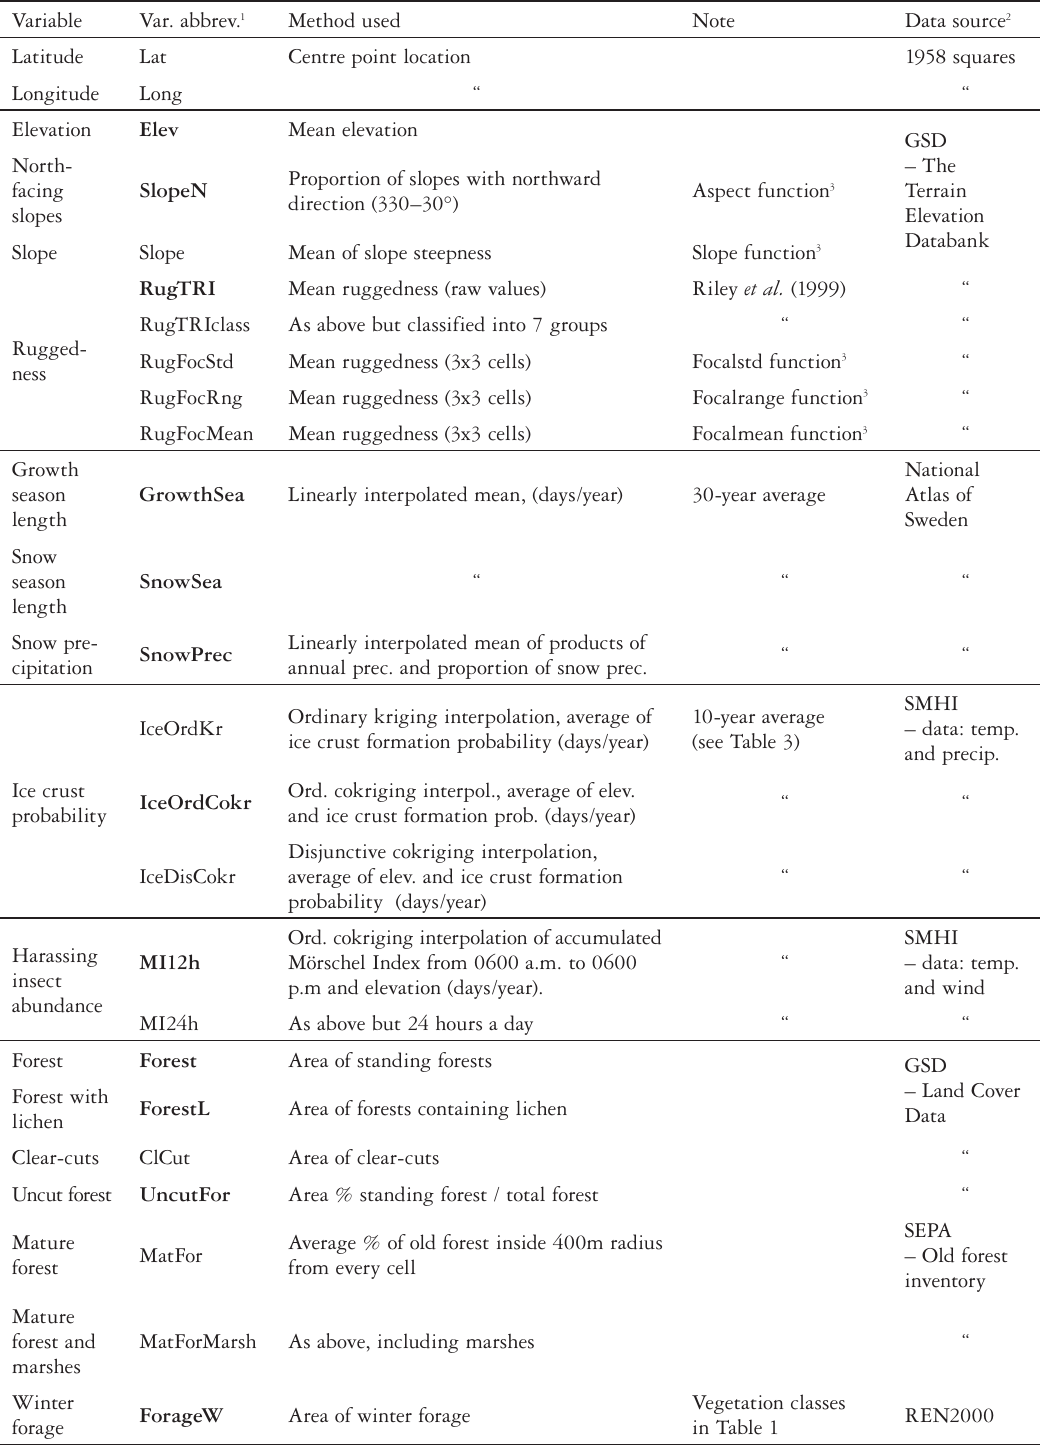
Table 2. Characteristics of the initial set of 37 variables. The variables are grouped according to their exogenous back- ground as conceptualised in Fig. 2. The 15 retained variables after variable reduction are in